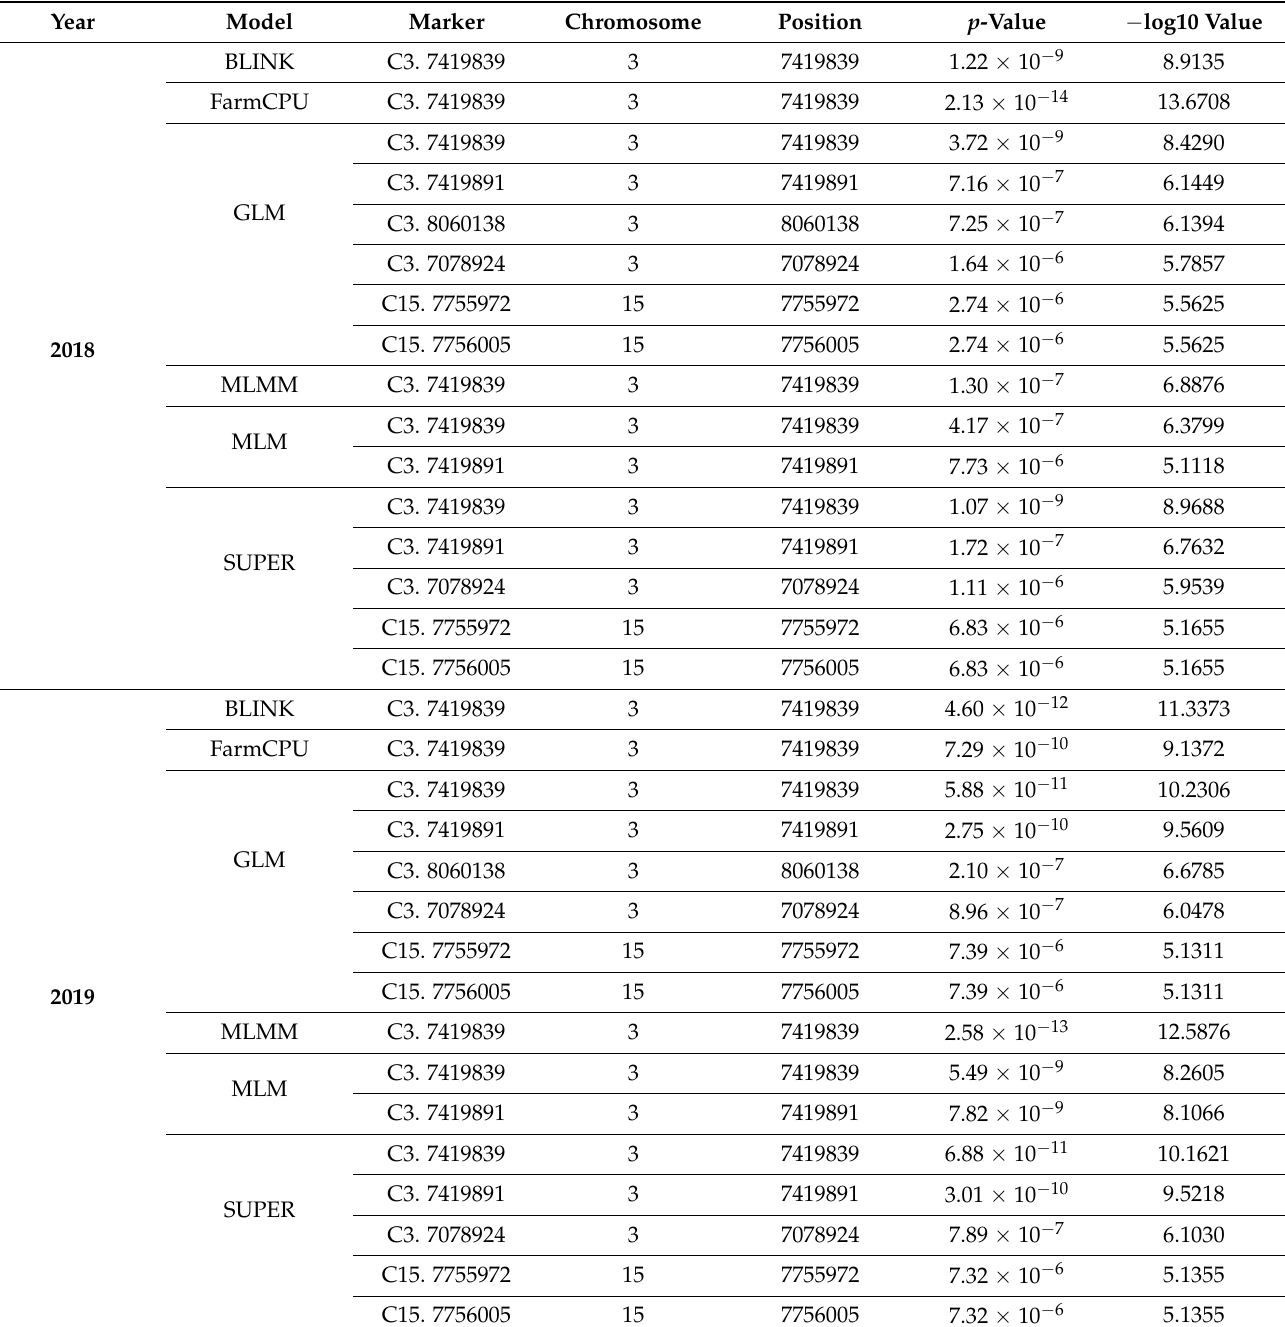
Table 1. Overview of highly significant marker associations for PM resistance identified using multivariate GWAS